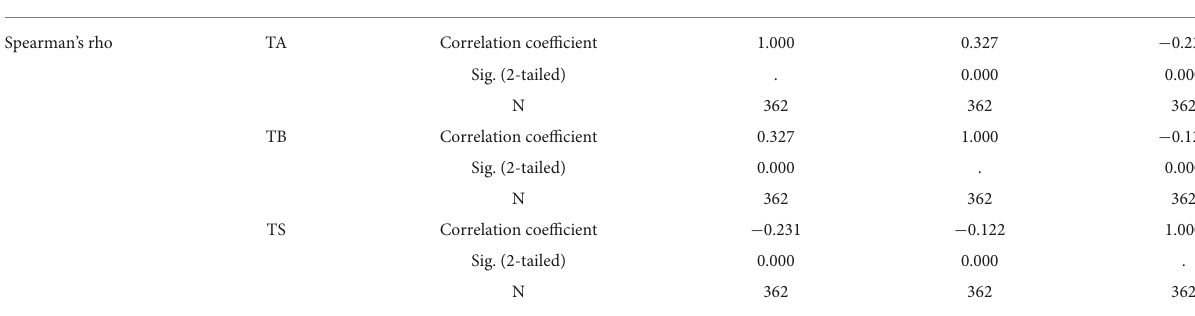
TABLE 2 Correlations among Chinese EFL teachers’ aggression, burnout, and success.